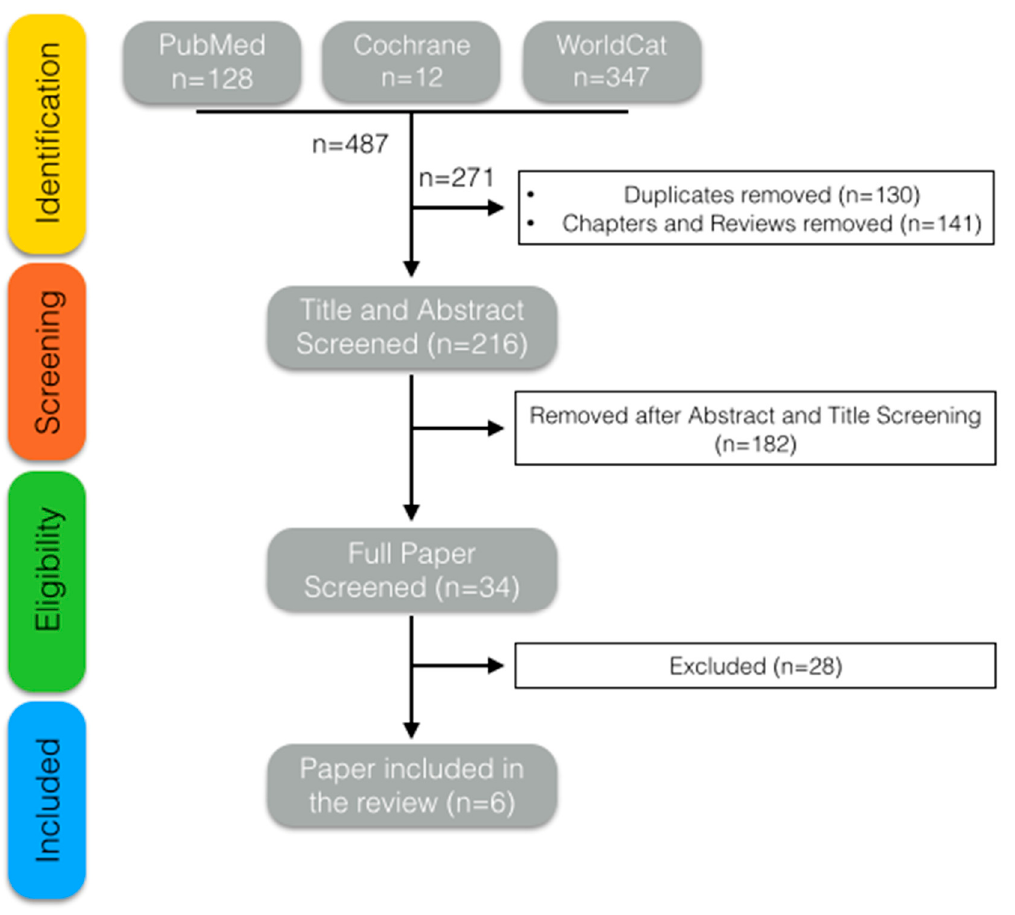
Figure 1. Search strategy.